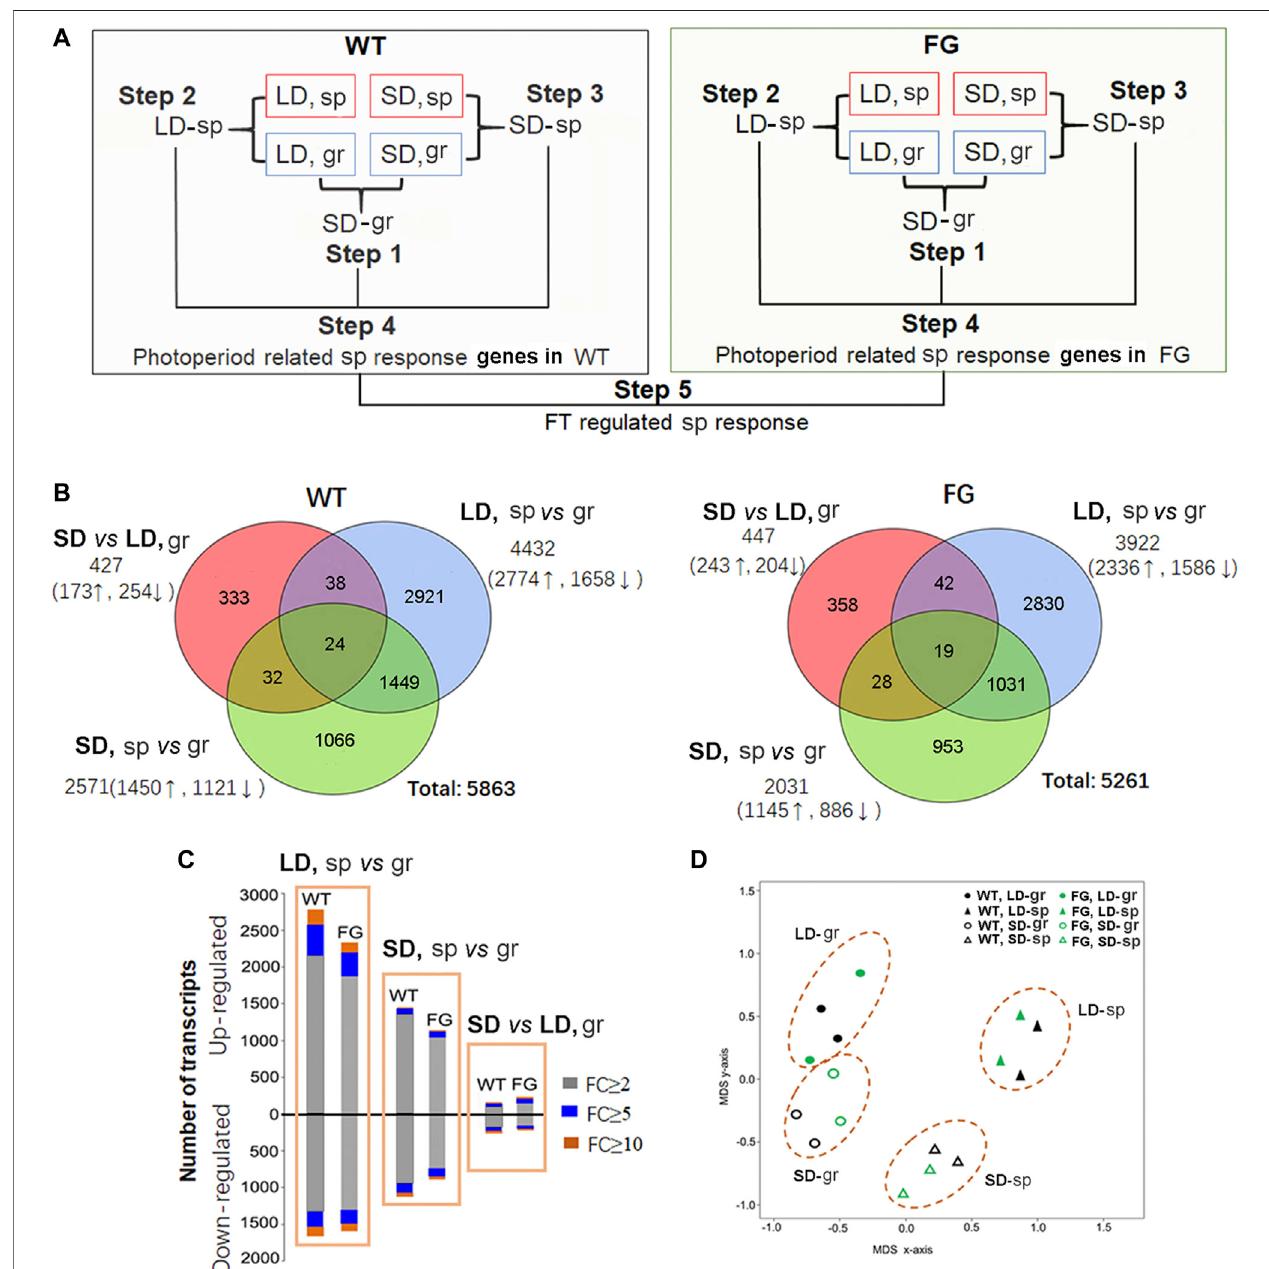
FIGURE4| Transcriptional responsestospace fl ight inwild-type (WT)and transgenic plants ( pHSP:FT ; pHSP:GFP ,FG)under thelong-day (LD) and theshort-day (SD) conditions, respectively. (A) Work fl ow of microarray data analysis. Analysis of differential expression genes (DEGs) consists of fi ve major steps: Step 1, analysis of SD photoperiod responsive genes in WT and FG plants grown on ground (gr) (SD-gr). Step 2, identi fi cation of DEGs in WT and FG plants under the LD in response to space fl ight (sp) in comparison with their controls on ground (LD-sp). Step 3, identi fi cation of DEGs in WT and FG plants under the SD in response to sp in comparisonwiththoseongr(SD-sp).Step4 , ComparedLD-spDEGsinWTandFGplantswithSD-spDEGs,respectively.Step5 , ComparedDEGsinWTwiththosein FG toidentifythe DEGsinvolved inFT pathway. (B) Venn diagram oftranscriptomic data. (C) Numbers ofDEGsin WT and FGplants ( p < 0.05) under theLDand the SD conditions, respectively, in response to sp. FC, fold change. (D) Principal component analysis demonstrates a strong difference between transcriptome of the sp- and the gr-sample under the LD and the SD conditions, respectively. Multidimensional scaling (MDS) of all DEGs in WT and FG under the LD and the SD, respectively, in response to